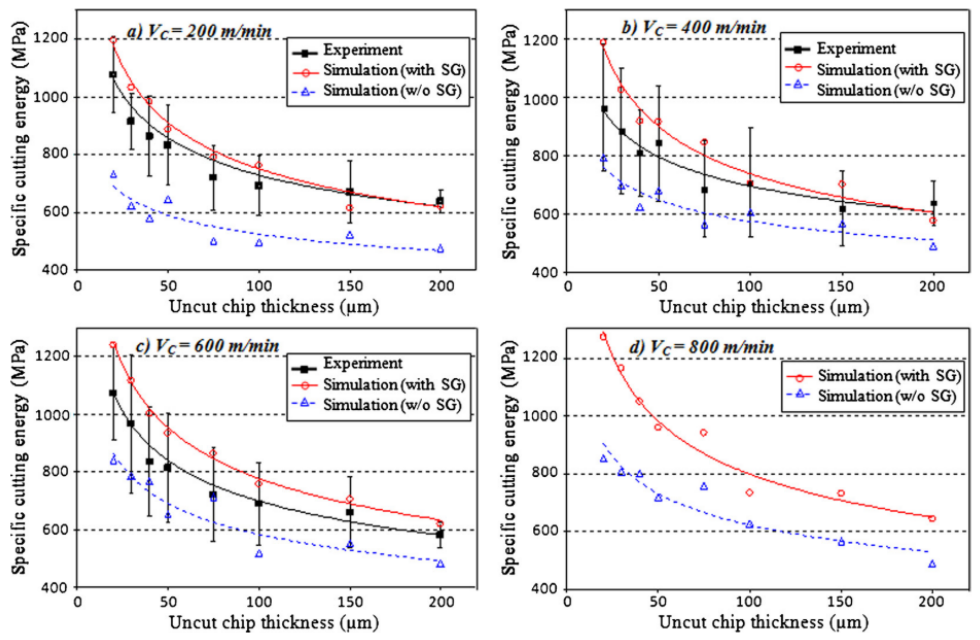
Figure 11. Predicted Specific Cutting Energy Variation during orthogonal cutting test for different cutting speed with and without SGT